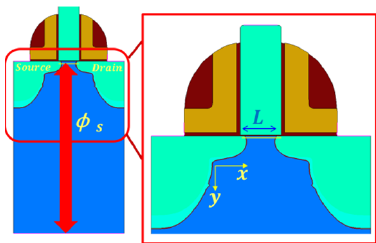
Figure 2. Schematic of the 130 nm MOSFET device with a polysilicon gate stimulated in TCAD. The surface potential is defined as the difference between the substrate electrostatic potential and the electrostatic potential (one nanometer below the channel surface). Table 1. Features of stimulated device data x i .